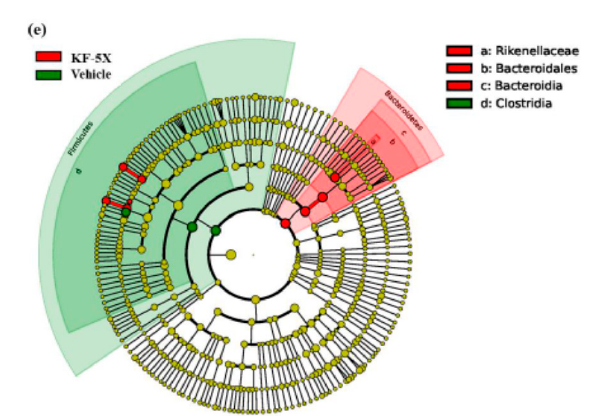
Figure 7. ( a ) Effects of kefir (KF) supplementation on principal coordinate analysis (PCoA) of the gut microbiota composition in mice based on the Bray–Curtis distance measure of samples in the relative abundance profiles of an operational taxonomic unit; ( b ) Effects of KF supplementation on the phylum-level gut microbiota composition of mice. Only phyla with top 10 average abundances were included, with other phyla collapsed into “Others”; the effects of KF supplementation on the phylum-level gut microbiota composition of mice in the ( c ) KF-1X and vehicle groups; ( d ) KF-2X and vehicle groups, and ( e ) KF-5X and vehicle groups. The cladogram was generated from the linear discriminant analysis effect size (LEfSe) analysis, showing the most differentially abundant taxa enriched in the microbiota of mice in ( c ) the KF-1X (red) and vehicle (green) groups, ( d ) the KF-2X (red) and vehicle (green) groups, and ( e ) the KF-5X (red) and vehicle (green) groups. Significant differential abundances in LEfSe comparisons are sorted by p values in ascending order: vehicle (glucose water), KF-1X (2.15 g/kg/day KF), KF-2X (4.31 g/kg/day KF), and KF-5X (10.76 g/kg/day KF).